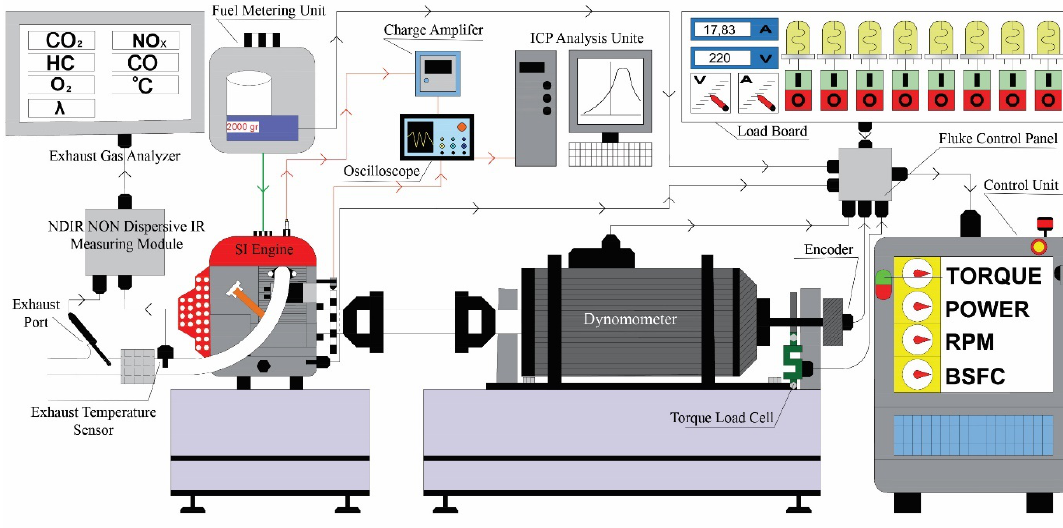
Figure 4. An overview of the experimental setup.